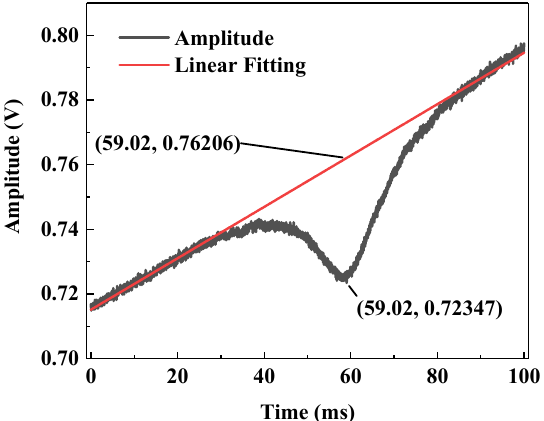
Figure 8. Measured C 2 H 2 absorption signal (black curve) with the reported three mirror-based gas cell at a concentration level of 2000 ppmv. The red curve shows the background fitting signal.